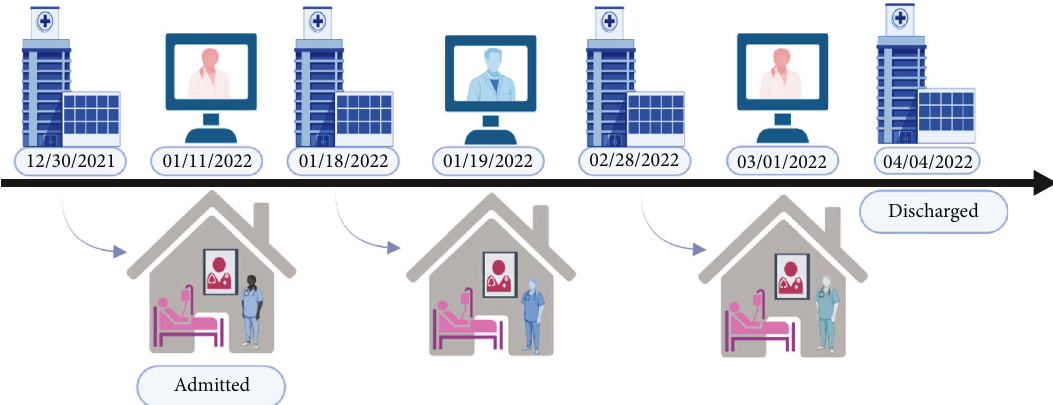
Figure 2: Timeline of intervention and outcomes. Admissions and discharge dates to the B&M hospital and the ACH program in Mayo Clinic Florida, created with